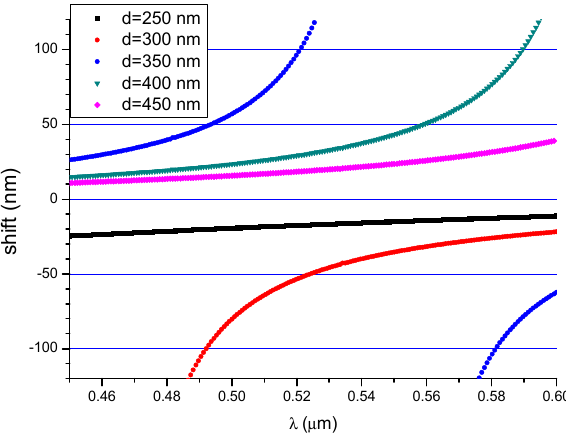
Figure 12. The shifts in the extrema as a function of wavelength for different waveguide thicknesses. The negative shift in the extrema (blue shift) is obtained over the entire wavelength range of the 250 nm thick waveguides. Both types of shifts (red and blue shift) are observed (some points are not visible due to their high values) in structures with thickness values of 300 and 350 nm. The shift of ∂ ( ∆ β ) extrema δλ diverges to infinity as the value of the function ∂λ tends to zero. A positive shift in the output signal extrema (red shift) is obtained over the whole range for waveguides with thickness values of 400 and 450 nm.